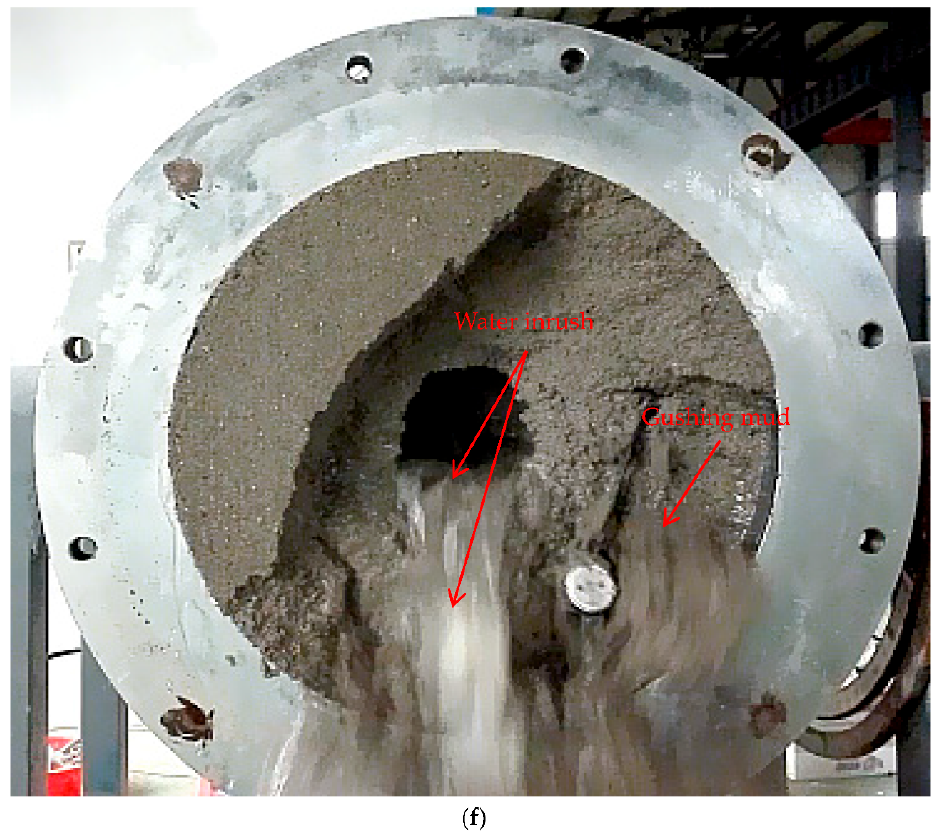
Figure 8. Water inrush stage at the bottom of arch. ( a ) The crack continued to extend about 20° to the upper left. ( b ) The crack extension. ( c ) Uplift of aquifuge rock. ( d ) A large crack appeared in the near vertical direction of the crack with the continuous expansion of the cracks. ( e ) The aquifuge rock broke down. ( f ) Water inrush occurred.